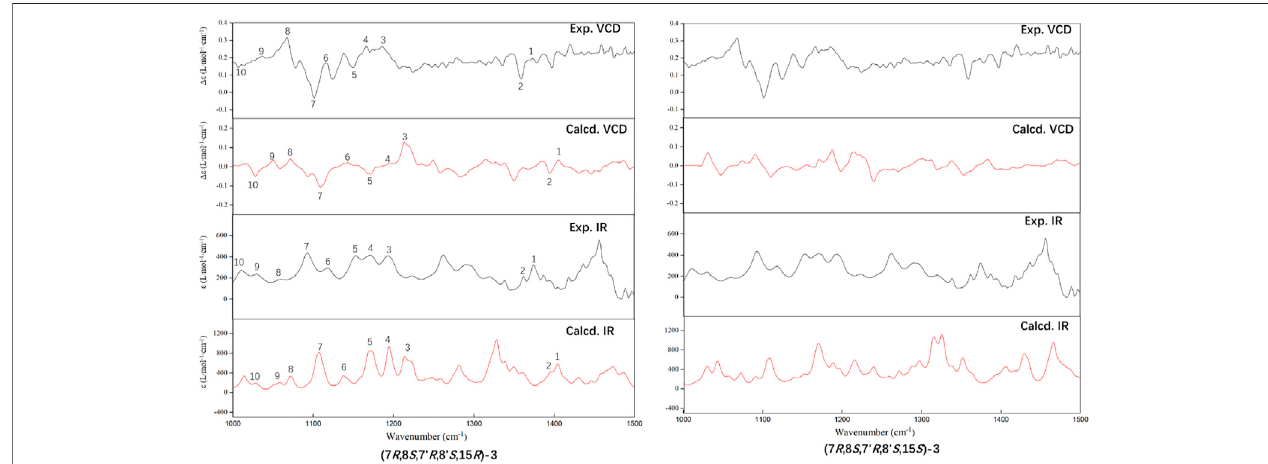
FIGURE4| Comparisonofthecalculated(Calcd.)VCDandIRspectraof(7 R ,8 S ,7 ′ R ,8 ′ S ,15 R )- 3 and(7 R ,8 S ,7 ′ R ,8 ′ S ,15 S )- 3 withtheexperimental(Exp.)spectraof 3 . The band half-width is 4 cm − 1 .